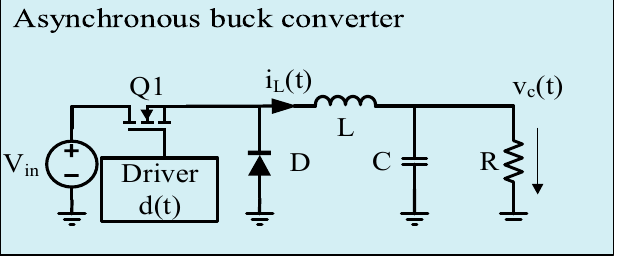
Figure 6. Asynchronous buck power stage and the iterative process resulting the inductor current and the capacitor voltage [2].